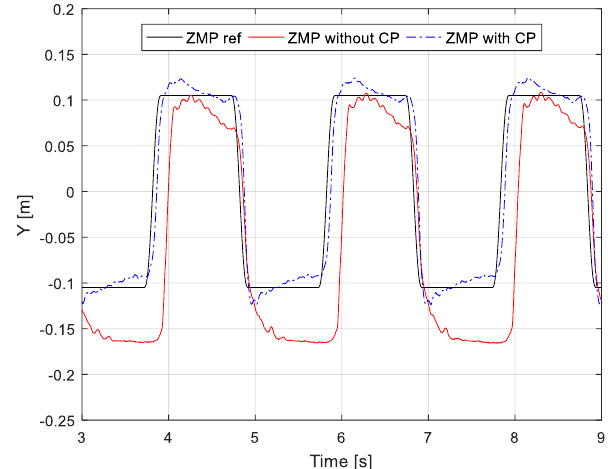
Figure 8. A test of the ZMP controller on an inclined surface. We commanded the CoM trajectory of the robot and measured ZMP data using the proposed and conventional ZMP controllers.